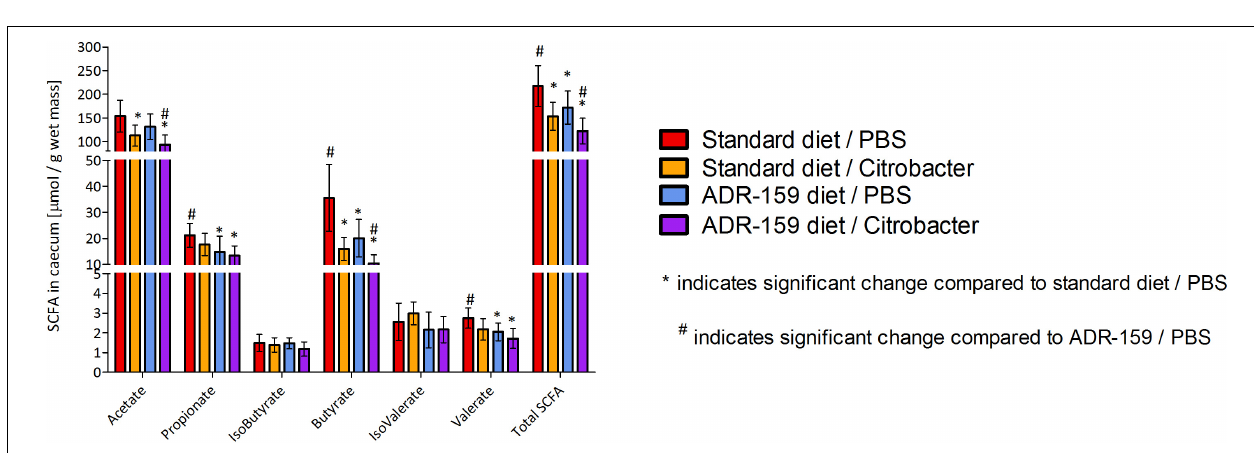
FIGURE 6 | (A) Gene expression levels in colon at sacrifice of ADR-159 fed animals dosed with PBS compared to standard fed animals (gray). Error bars represent 95% confidence interval. Value 1 corresponds to no change in expression. *Indicates significant change compared to standard diet/PBS, # indicates significant change compared to ADR-159/PBS. (B) Gene expression levels in colon at sacrifice of standard (light gray) and ADR-159 (dark gray) fed animals dosed with Citrobacter compared to their PBS dosed counterparts. Error bars represent 95% confidence interval. Value 1 corresponds to no change in expression. ∗ Indicates significant change compared to standard diet/PBS, # indicates significant change compared to ADR-159/PBS.